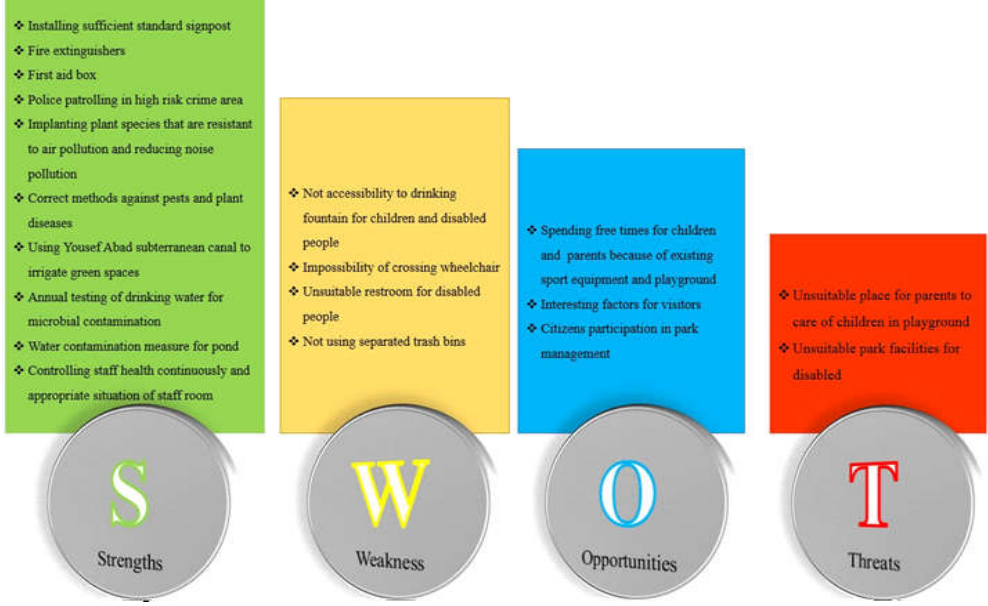
Fig. 6: Nezami Ganjavi SWOT